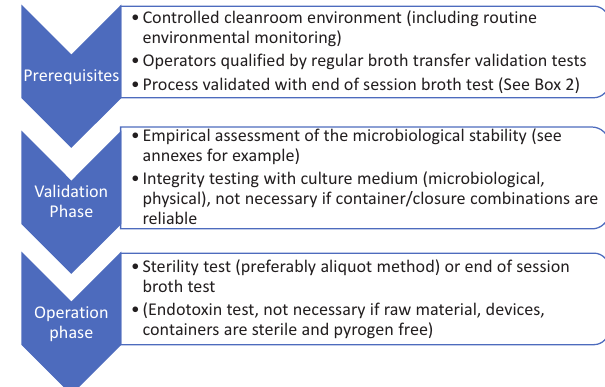
Figure 2: Summary of the strategy in case of batch preparation using the same process for immediate use or for stock.